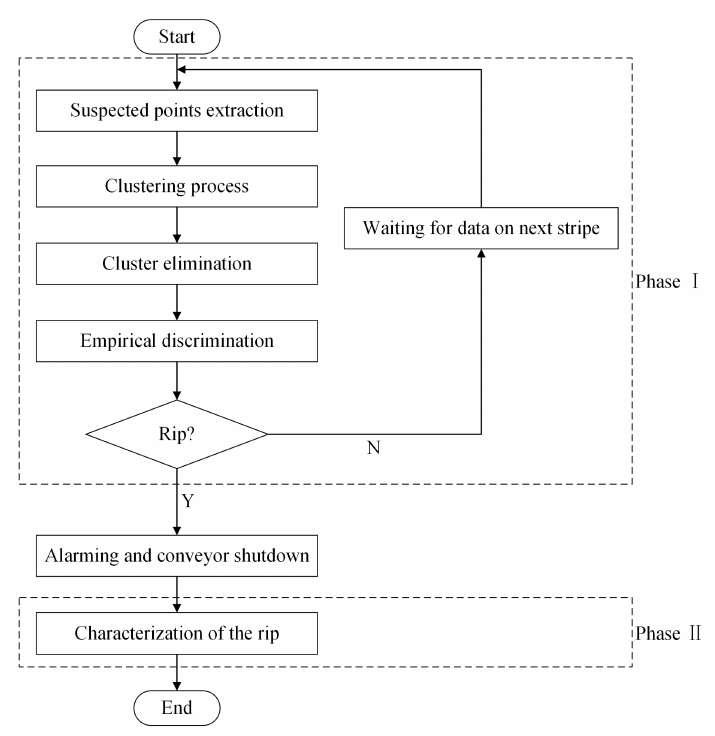
Figure 2. Flowchart of algorithm in this